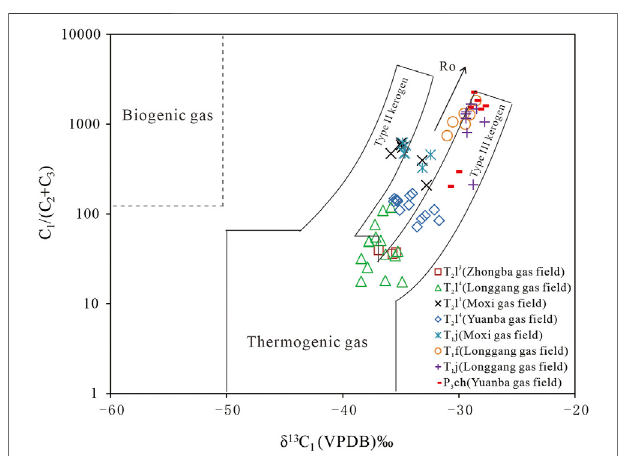
FIGURE 3 | Identi fi cation of natural gas from the Leikoupo Formation in the Sichuan Basin using Whiticar ’ identi fi cation Chart [(modi fi ed after Whiticar (1999)].